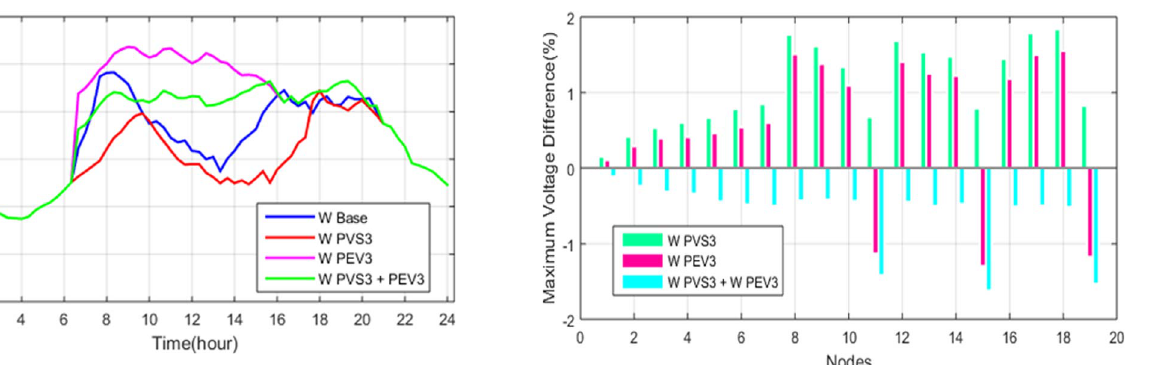
Figure 21. Analysis of system voltage differences in maximum level during winter.